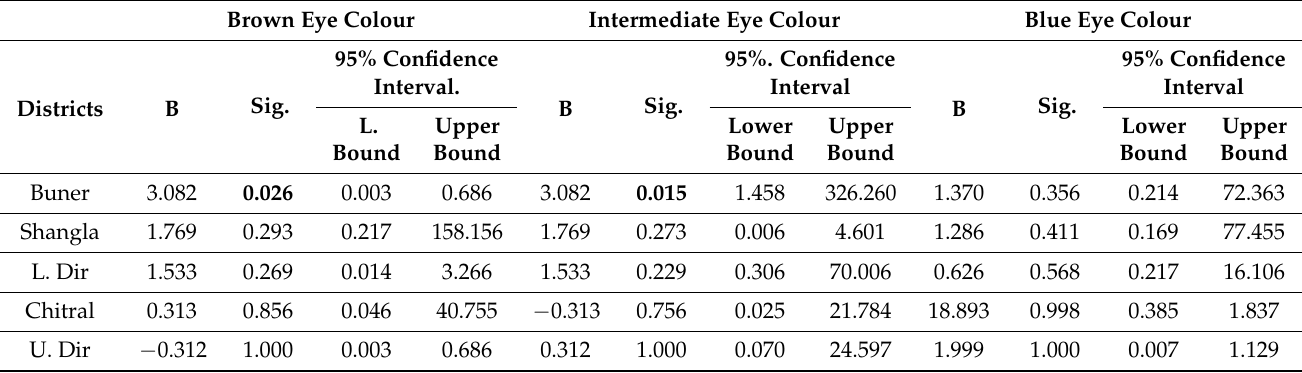
Table 5. Result of Multinomial logistic regression analysis between Districts and eye colour. The bold value indicated signi fi cant variable with eye colour .